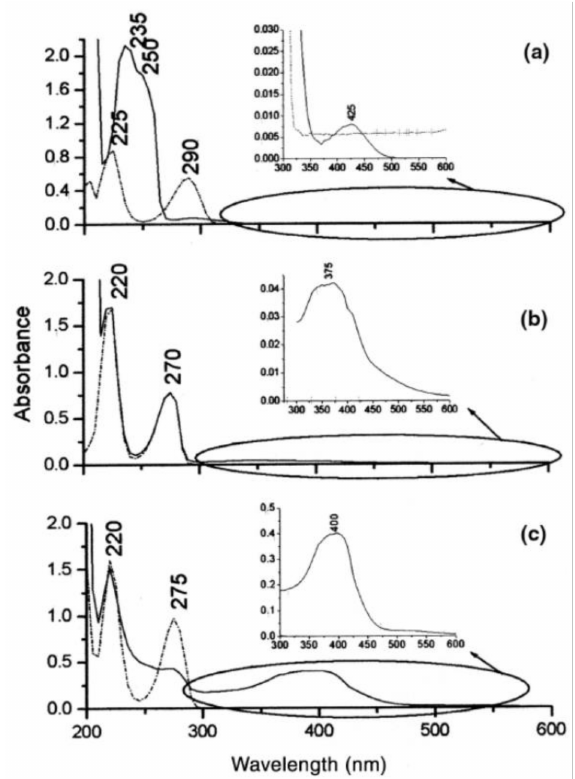
Figure 10. Experimental results obtained with an optical biosensor based on sol–gel immobilized lac- case. ( a ) Absorption spectra of hydroquinone (dashed line) and laccase-reaction product (continuous line), ( b ) the same for resorcinol, ( c ) the same for catechol. In the different insets, the spectra in the 300–600 nm region. (Reprinted with permission from